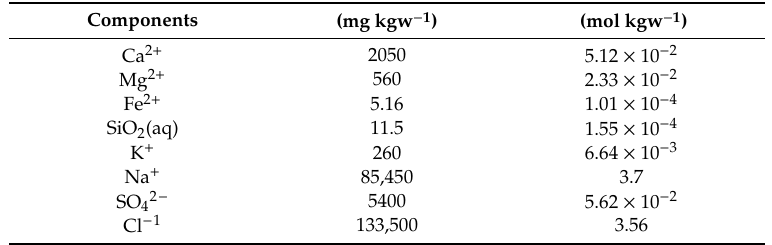
Table 3. Chemical composition of solution used as input in the